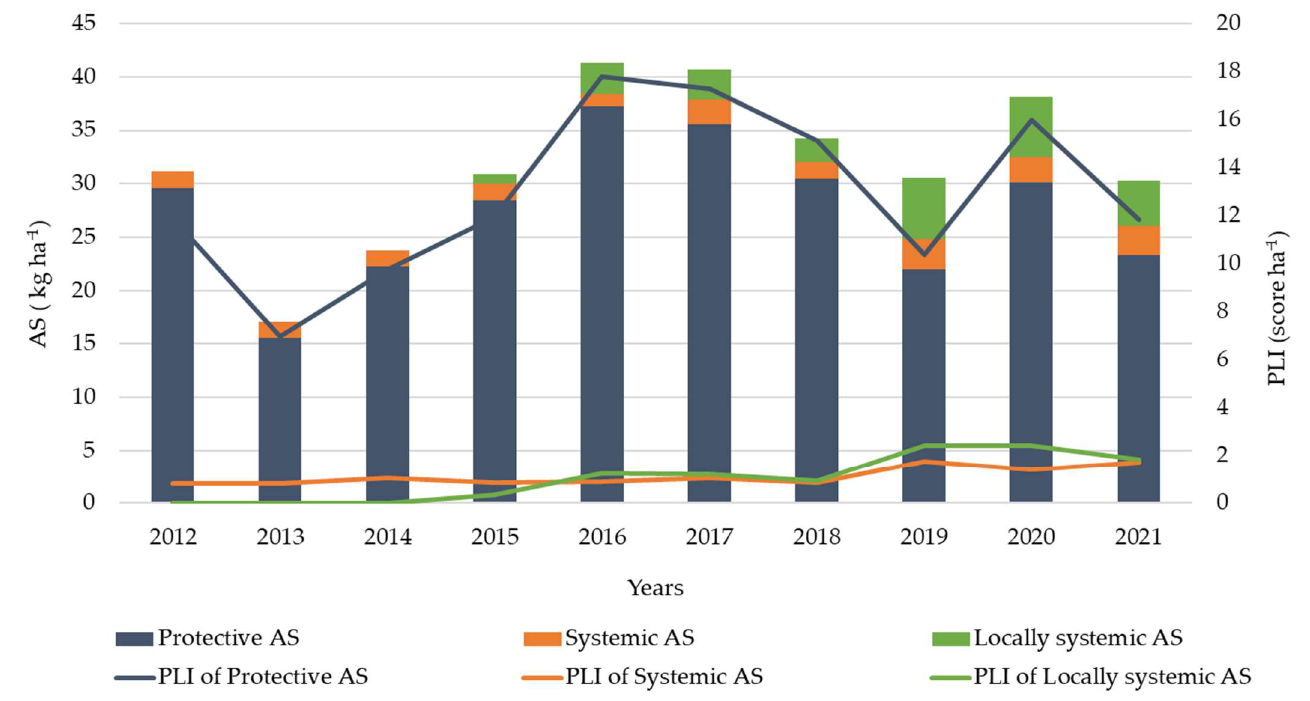
Figure 2. The total consumption of protective, locally systemic and systemic active substances (AS) and Pesticide Load Indicator (PLI) of protective, locally systemic and systemic active substances (AS) per hectare referred to the six farms considered during the 2012–2021 apple-growing seasons.